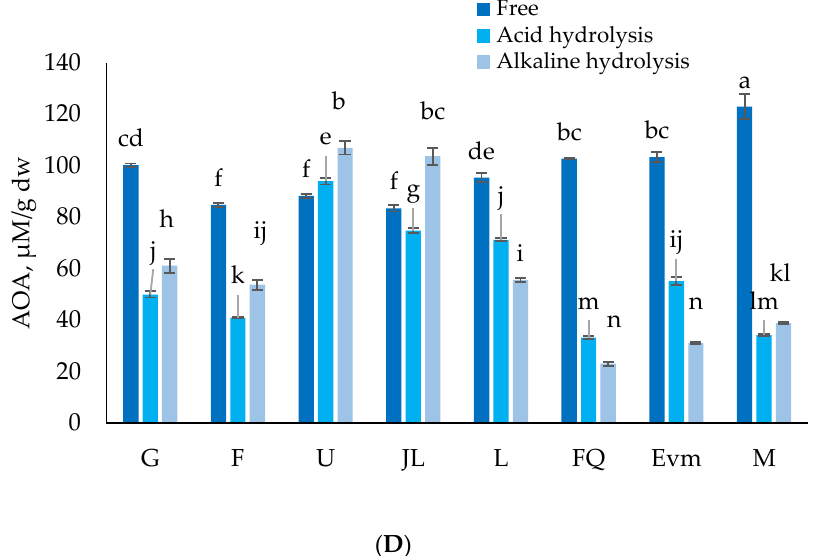
Figure 2. Antioxidant activity of free and bound phenolics in eight peach varieties’ peel extracts ( µ MTE/g dw) by ( A ) DPPH, ( B ) ABTS, ( C ) FRAP and ( D ) CUPRAC assays. Different letters (a–n) within chart columns indicate significant differences ( p < 0.05) between treatments as analyzed by two-way ANOVA and the Tukey test (n = 3). G—“Gergana”, F—“Filina”, U—“Ufo 4”, JL—“July Lady”, L—“Laskava”, FQ—“Flat queen”, Evm—“Evmolpiya”, M—“Morsiani 90”. The results for the bound phenolic compounds released by acid hydrolysis were sub- Table 2. Enzyme-inhibitory activities ( α -glucosidase, lipase, α -amylase, and acetylcholinesterase (AChE)) of free and bound phenolics of eight peach varieties’ peel extracts, IC 50 , mg/mL. Samples